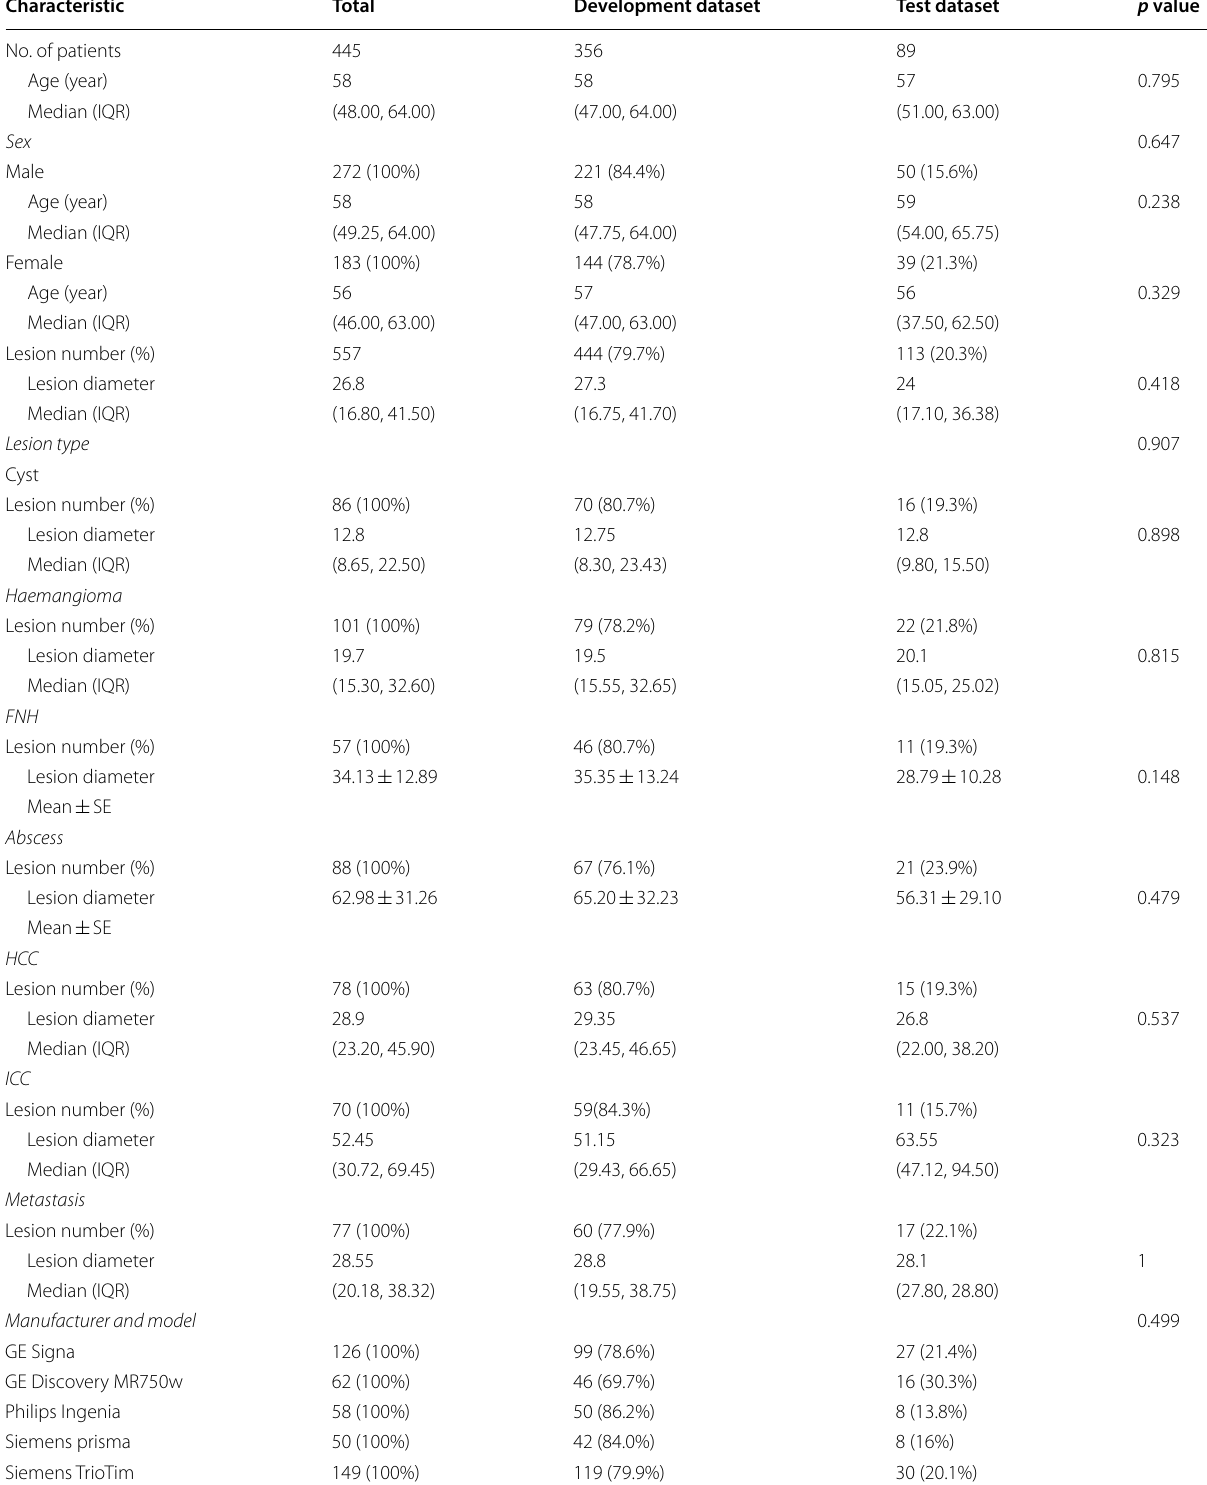
Table 2 Data and patient